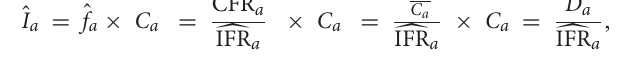
Frontiers in Microbiology |